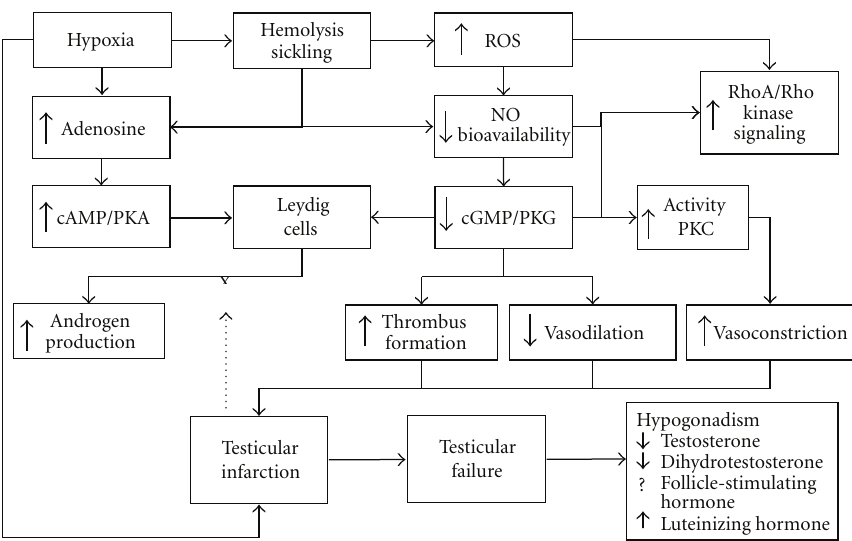
Figure 1: Schematic pathophysiology of hypogonadism and testicular infarction in sickle cell disease. The dashed arrow represents the blocking e ff ect of gonadal failure over cyclic nucleotide-stimulated androgen production.